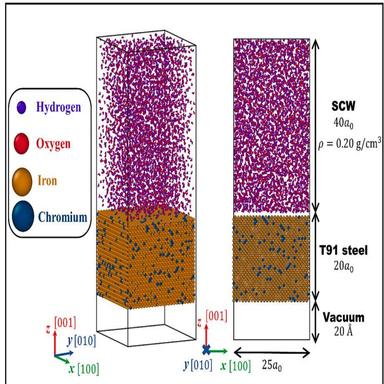
The schematic diagram of the Fe-9Cr steel-SCW interface model. The size of the simulation box and the color of different elements are marked in the Figure. Herein, yellow, cyan, red and blue balls represent iron, chromium, oxygen and hydrogen atoms, respectively. (For interpretation of the references to color in this figure legend, the reader is referred to the web version of this article.)